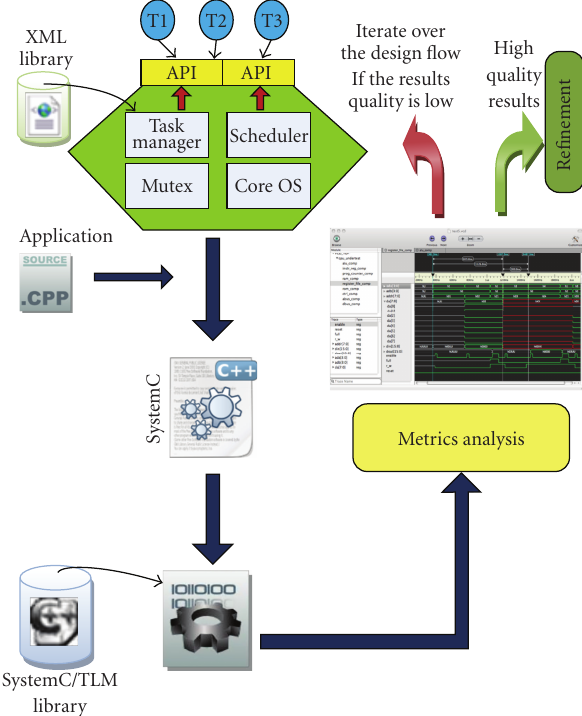
Figure 4: The DOGME tool brings facilities to manipulate the components of the library. These components model RTOS services for the control of an RSoC platform. In the library the services are described both by a SystemC generic source code and an XML exchange file. The designer graphically instantiates the components, then the tool automatically adds debug components for metric evaluation into the specification and generates the code of the corresponding platform. The platform is compiled and linked with the SystemC libraries and simulated thanks to graphical interfaces. The designer can finally evaluate the metrics of his platform and can take decisions about exploration or